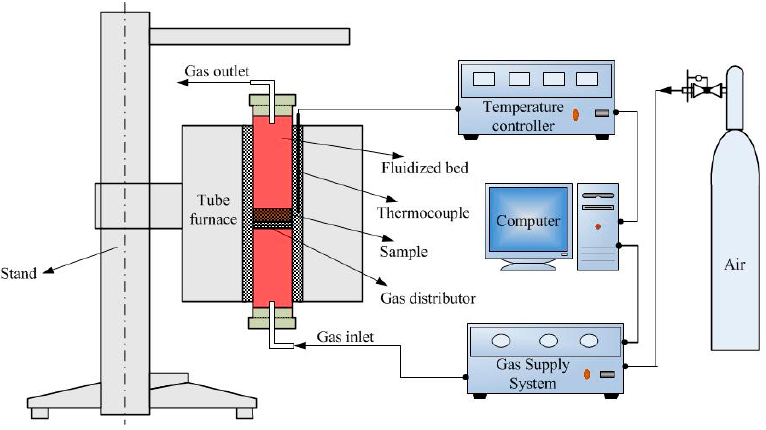
Figure 4. Schematic of fluidized calcination experimental apparatus.